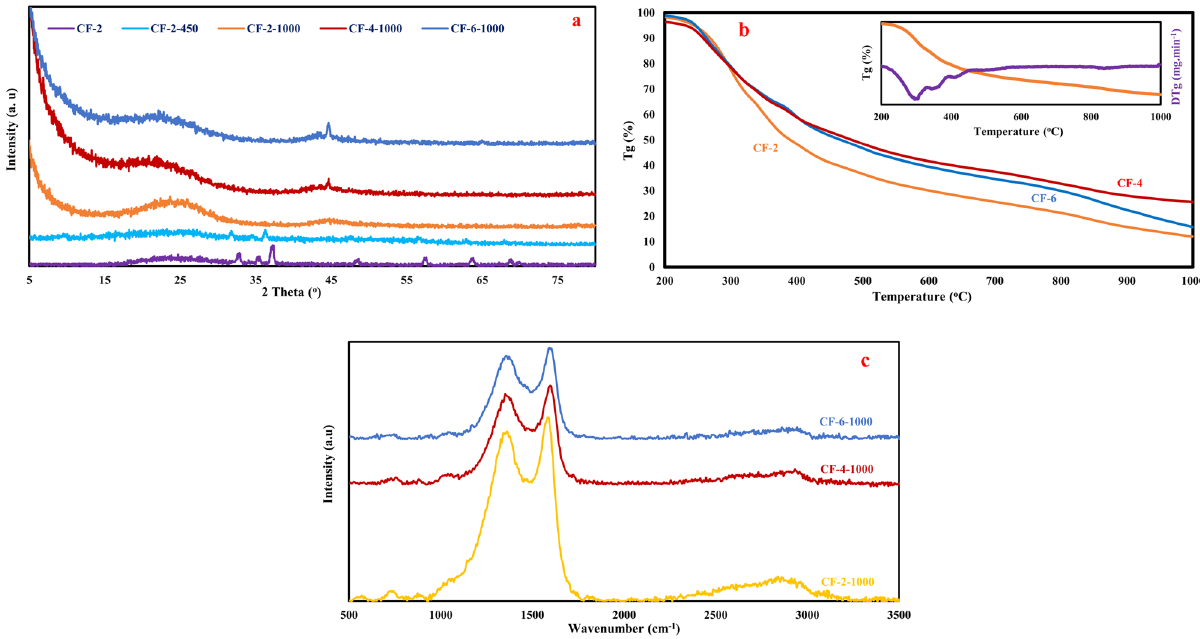
Figure 1. Structural development of the synthesized foam during thermal treatment ( a ) X-ray diffraction patterns of the synthesized foams, ( b ) Thermal gravimetric analysis results of the prepared foams with 2, 4 and 6 g of Zn(NO 3 ) 2 .6H 2 O, ( c ) Raman Spectra of the carbon